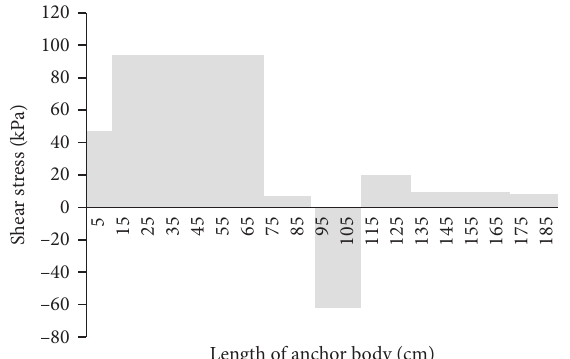
Figure 17: Shear stress distribution of anchor 220cm.